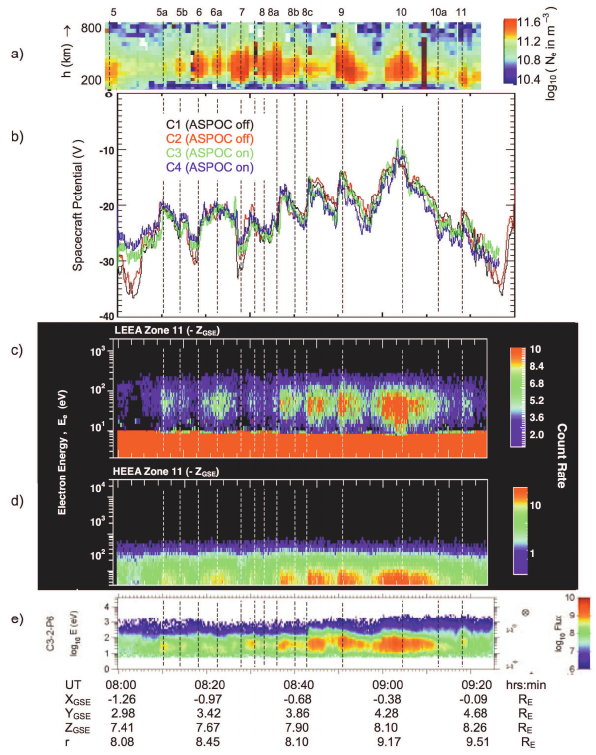
Fig. 6. From top to bottom: (a) electron density measurements made using the ESR field-aligned antenna, (b) spacecraft potential measurements from the EFW instrument on all four Cluster space- craft, (c) electron measurements from the HEEA detector of the PEACE instrument on Cluster 3, (d) electron measurements from the LEEA detector of the same instrument and (e) ion measurements from the CIS instrument on Cluster 3. The ESR measurements have been time-shifted to give the best agreement with the Cluster obser- vations at events 5 and 11. (From Lockwood et al.,